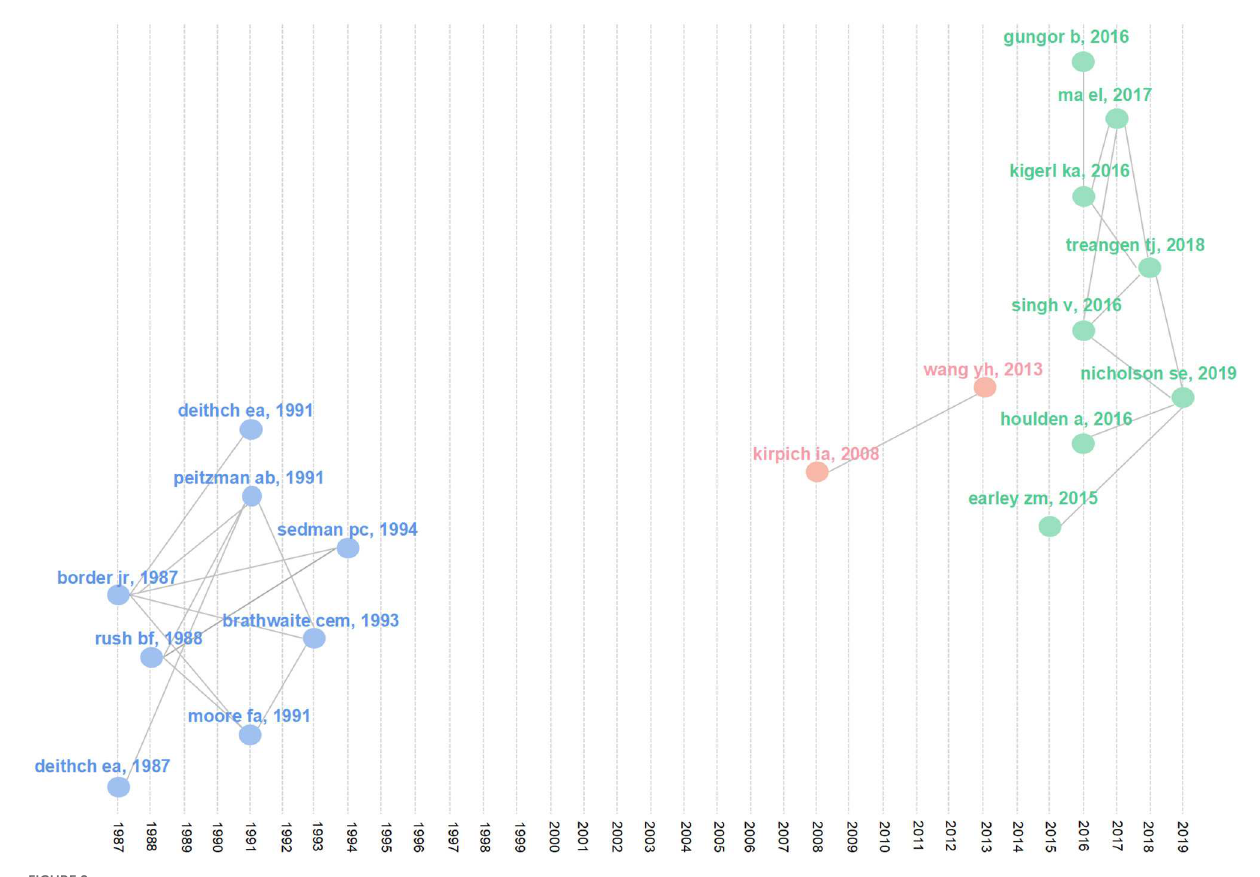
FIGURE8 Historical direct citation network of key documents in gut microbiota and trauma